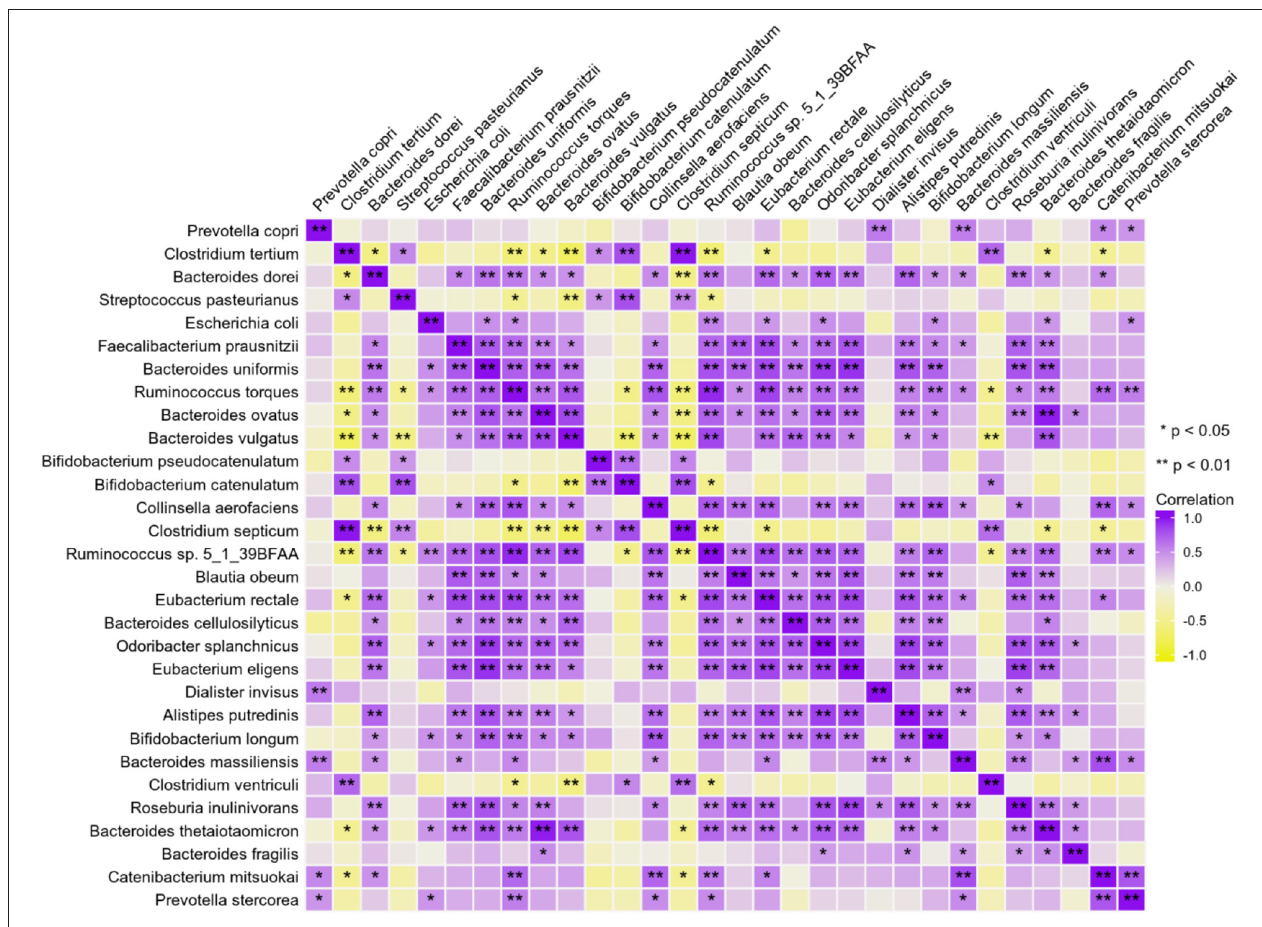
FIGURE 4 | Correlation analysis of intestinal microbiota in children with T1D.